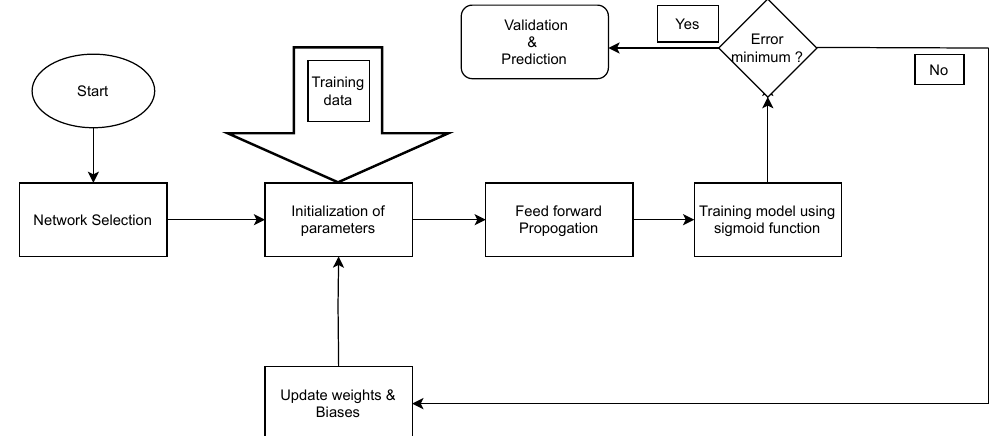
Figure 3. Flow chart of the artificial neural network.